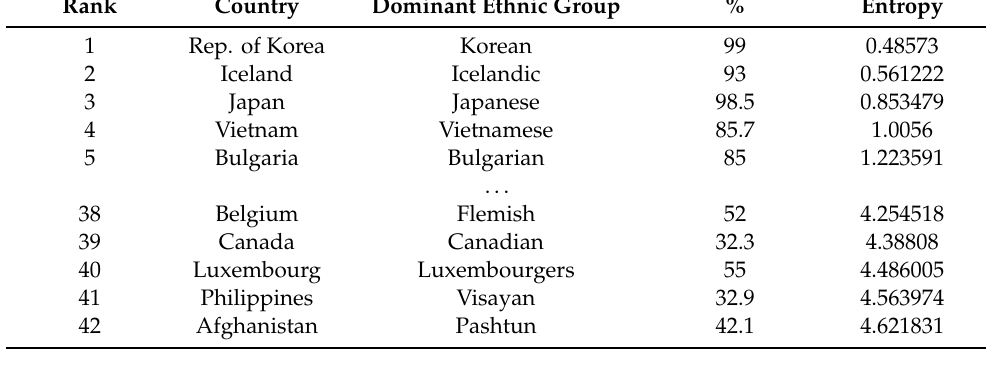
Figure 5. Relationship of entropy and dominant group. Table 5. Entropy and dominant group of each country.